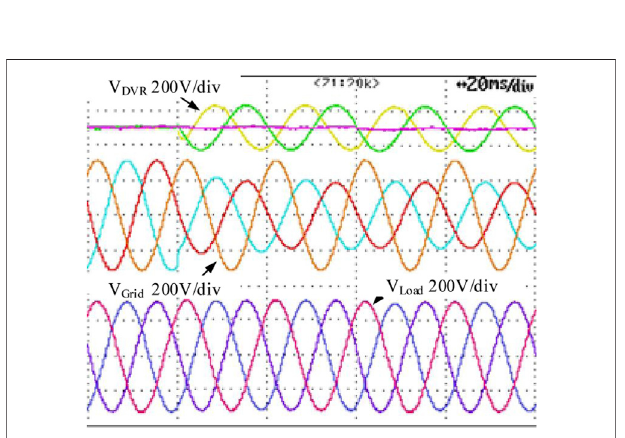
FIGURE 15 | Experimental results of dual-phase voltage sag compensation.